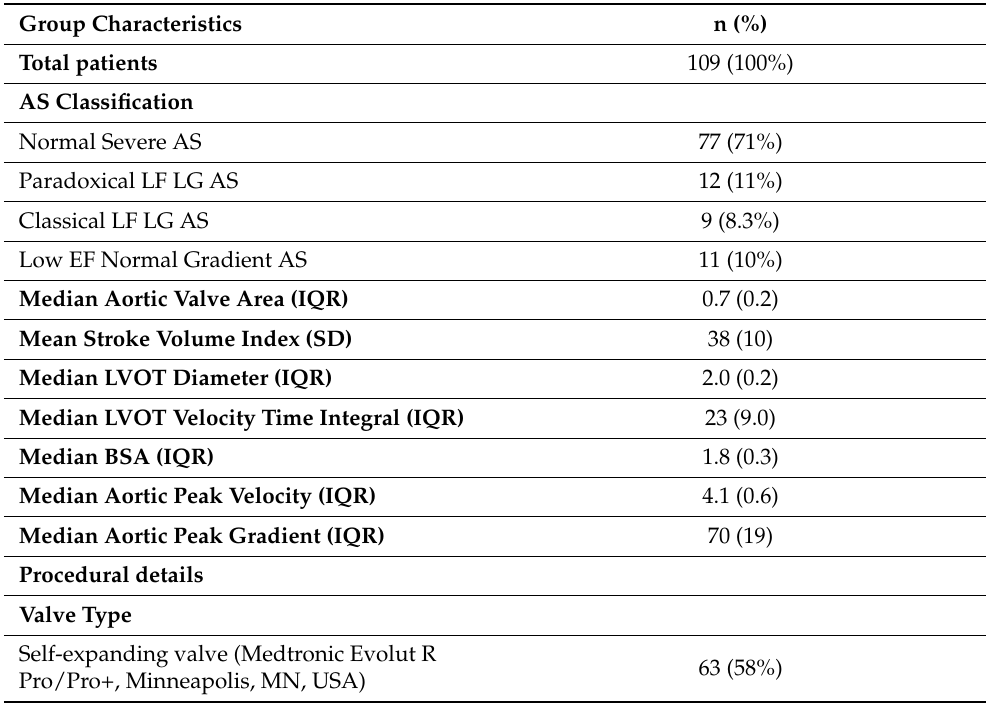
Table 2. Aortic stenosis subtypes, echocardiographic findings and procedural